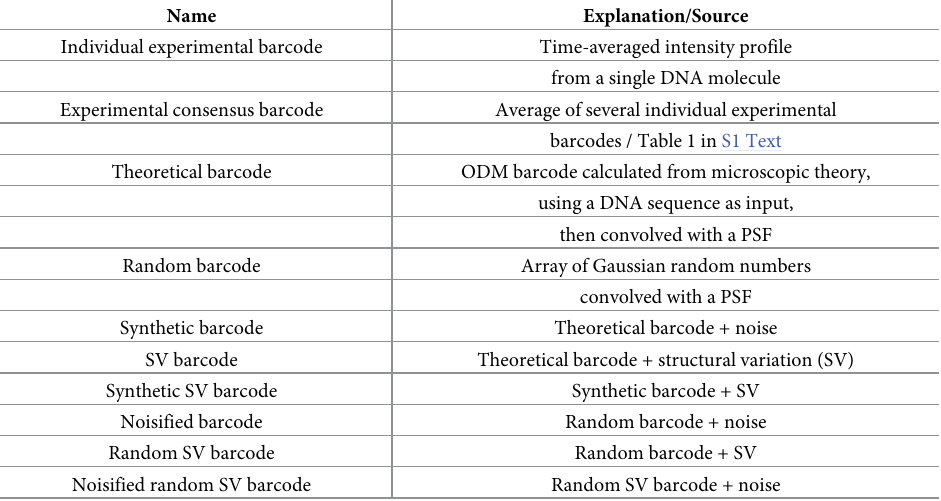
Table 1. List of the different types of DNA barcodes used in this